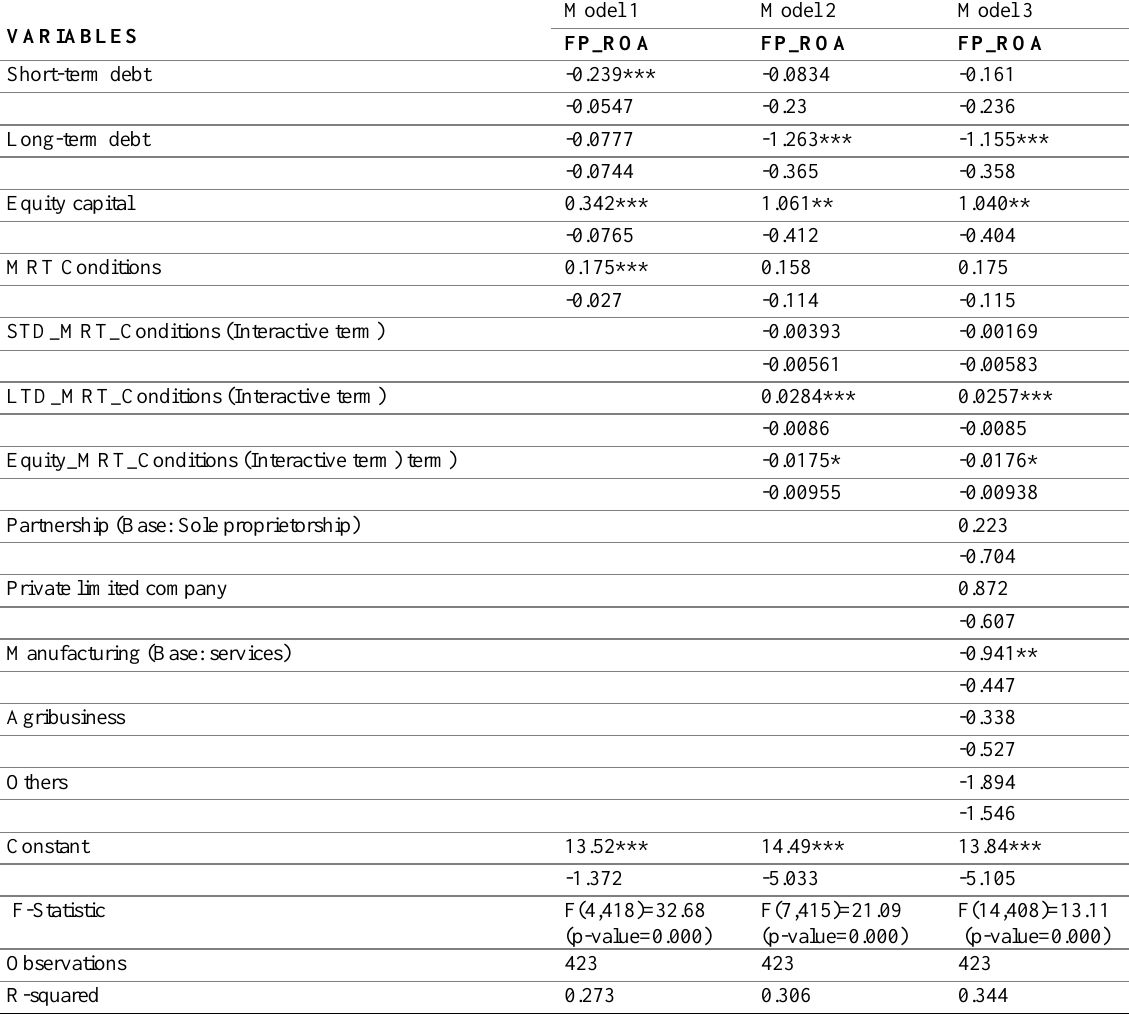
Table 4: Moderation Effects of Market